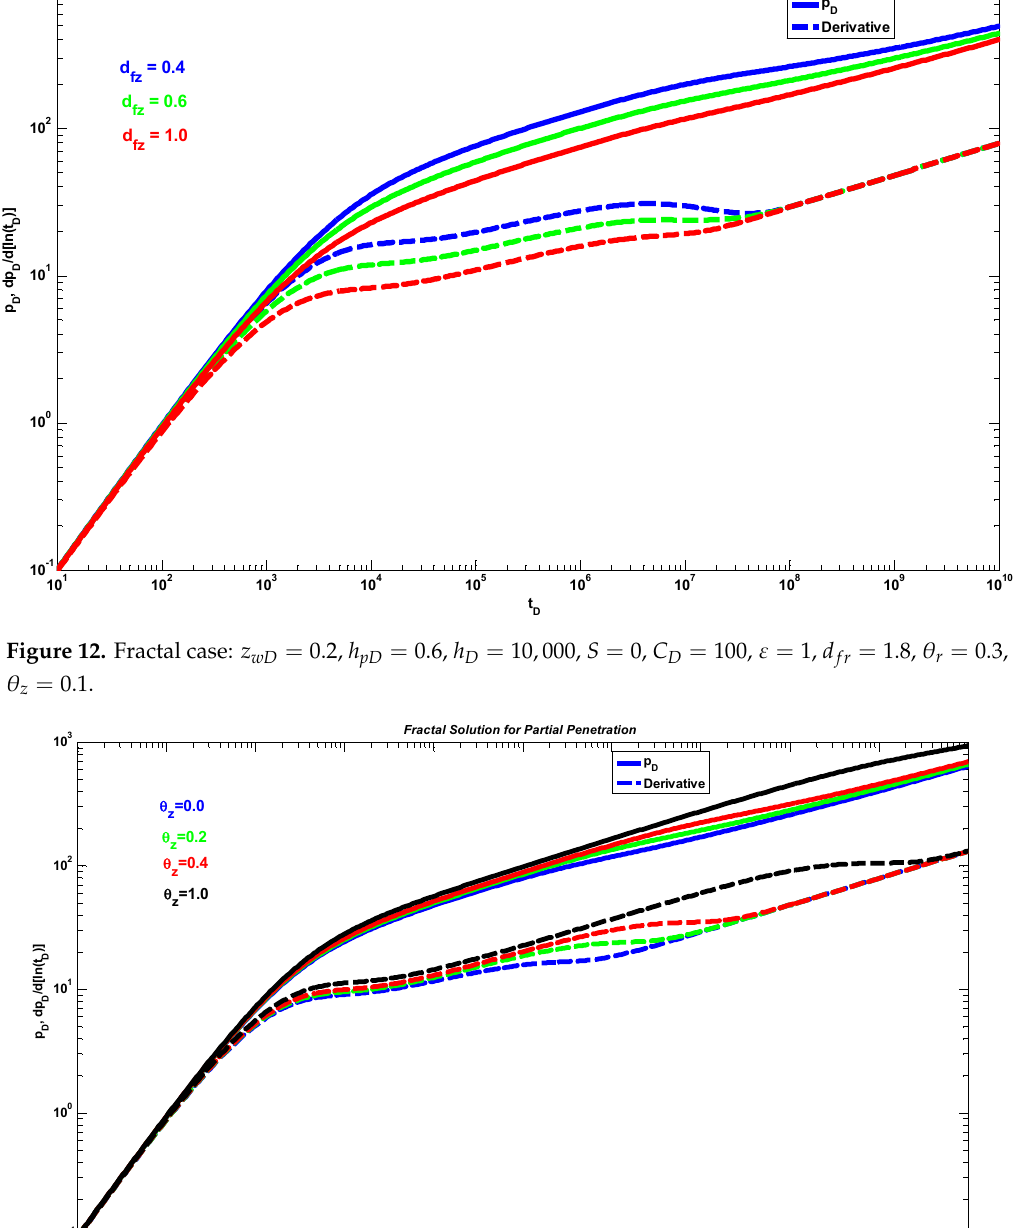
10 of 17 Figure 11. Fractal case : 𝑧 (cid:3050)(cid:3005) = 0.2 , ℎ (cid:3043)(cid:3005) = 0.6 , ℎ (cid:3005) = 10,000 , 𝐶 (cid:3005) = 100 , 𝜀 = 1 , 𝑑 (cid:3033)(cid:3045) = 1.8 , 𝜃 (cid:3045) = 0.3 , 𝑑 (cid:3033)(cid:3053) = 1.0 , 𝜃 (cid:3053) = 0.2 .